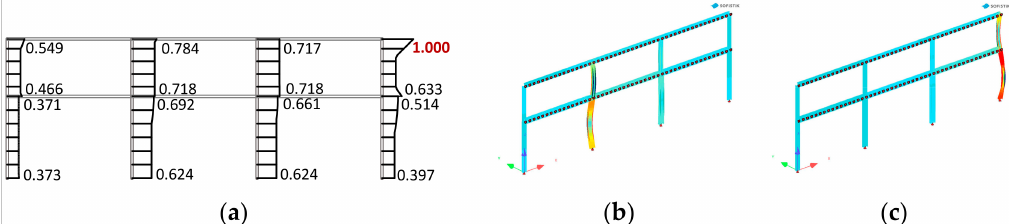
Figure 14. Implementation of the General method on the VHS frame: ( a ) utilization of the columns for the determination of α utl,k ; ( b ) first out-of-plane buckling mode of the frame; ( c ) first out-of-plane buckling mode that includes the most stressed column.